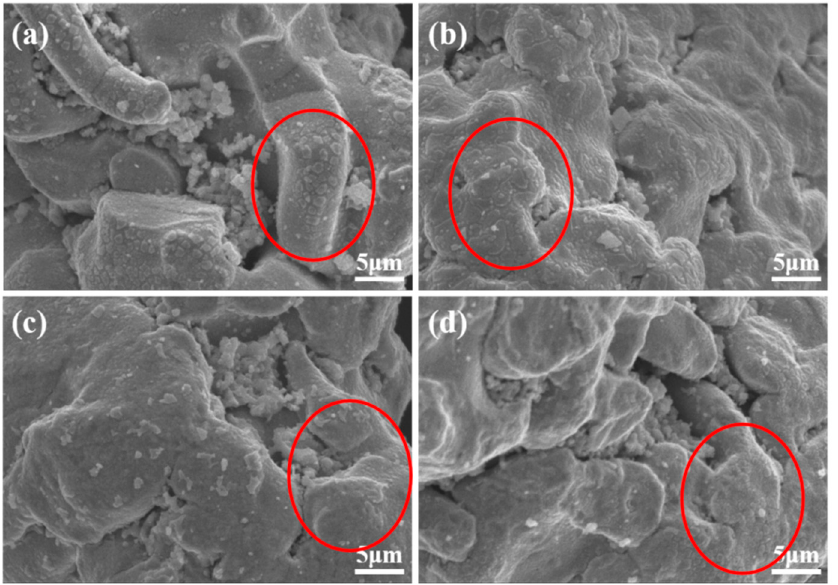
Figure 7. SEM images of iron powder coated using photolysis in diethyl zinc solutions of different concentrations: ( a ) 0.24 mol/L, ( b ) 0.32 mol/L, ( c ) 0.40 mol/L, and ( d ) 0.48 mol/L.